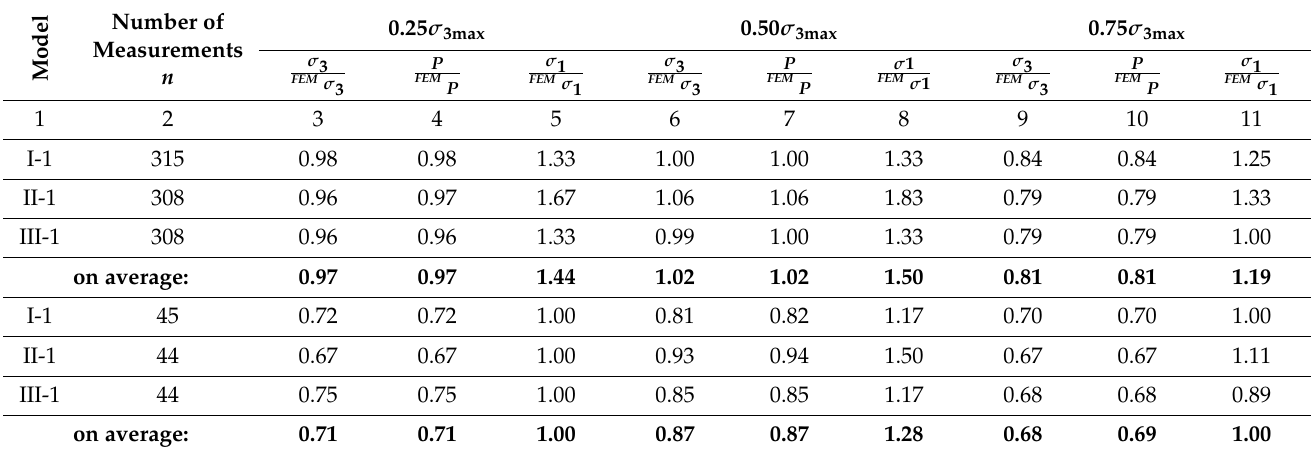
Table 10. Compared mean values P and σ obtained from the tests and FEM